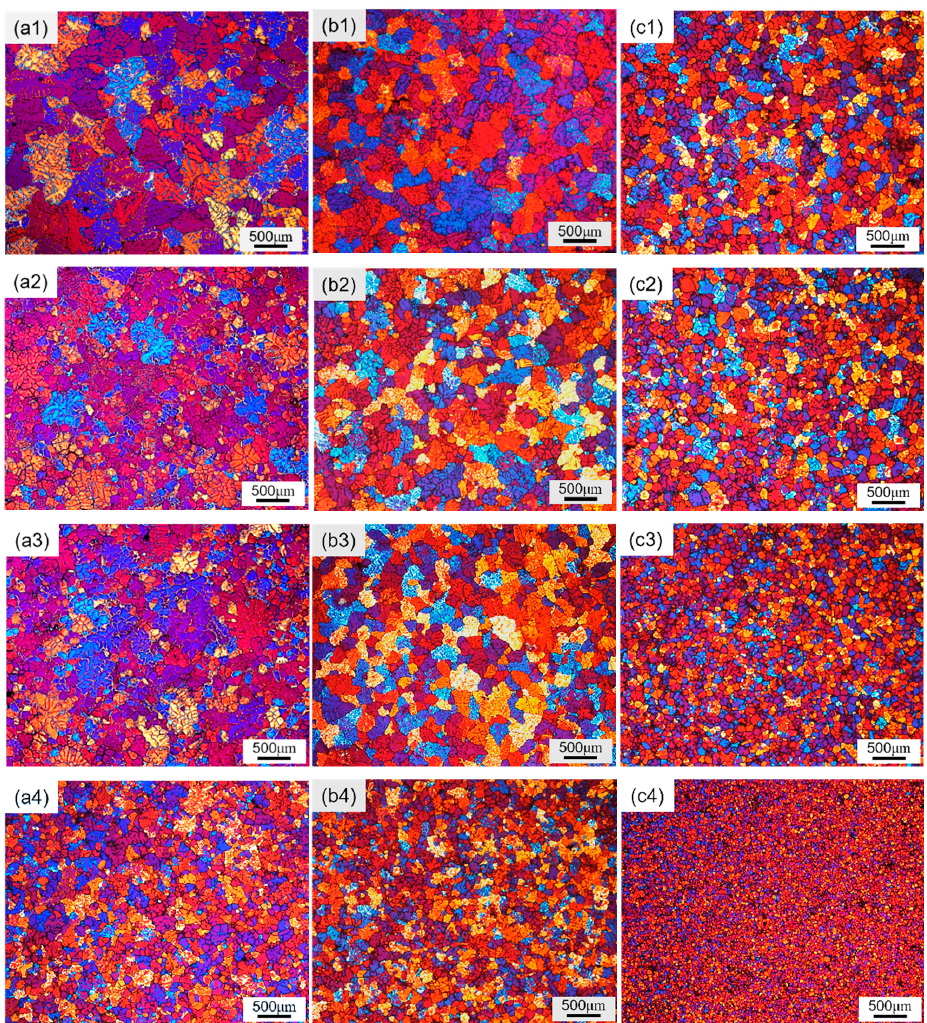
Figure 3. Polarized light micrographs showing the microstructural characterization of Al-Zn-Mg-Cu-Zr alloy with di ff erent melt treatments: ( a ) without treatment, ( b ) with electromagnetic stirring (EMS), ( c ) with IC-AEMS, and pouring temperature: ( 1 ) 670 ◦ C, ( 2 ) 660 ◦ C, ( 3 ) 650 ◦ C, ( 4 ) 640 ◦